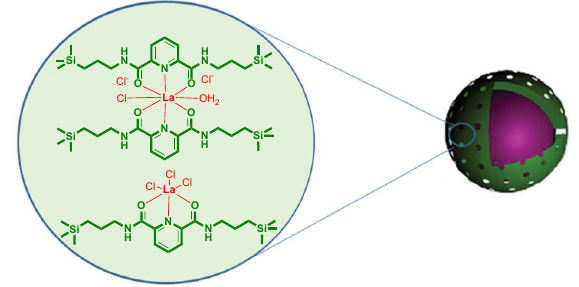
Figure 1. Schematically representation of